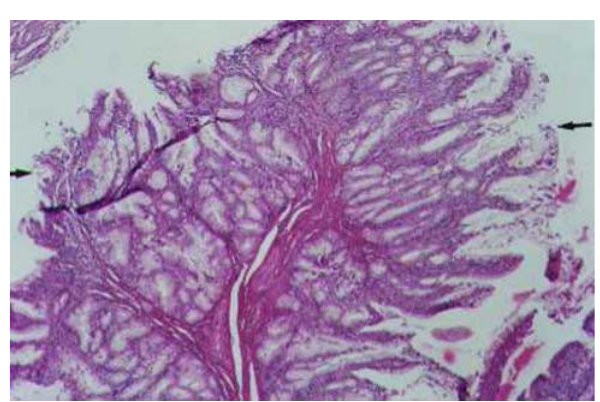
FIGURA 20 - Fotomicrografia mostra região da eversão com hiperplasia da mucosa. Suíno 16. Grupo II. Aumento 63x. Coloração pela hematoxilina- eosina.